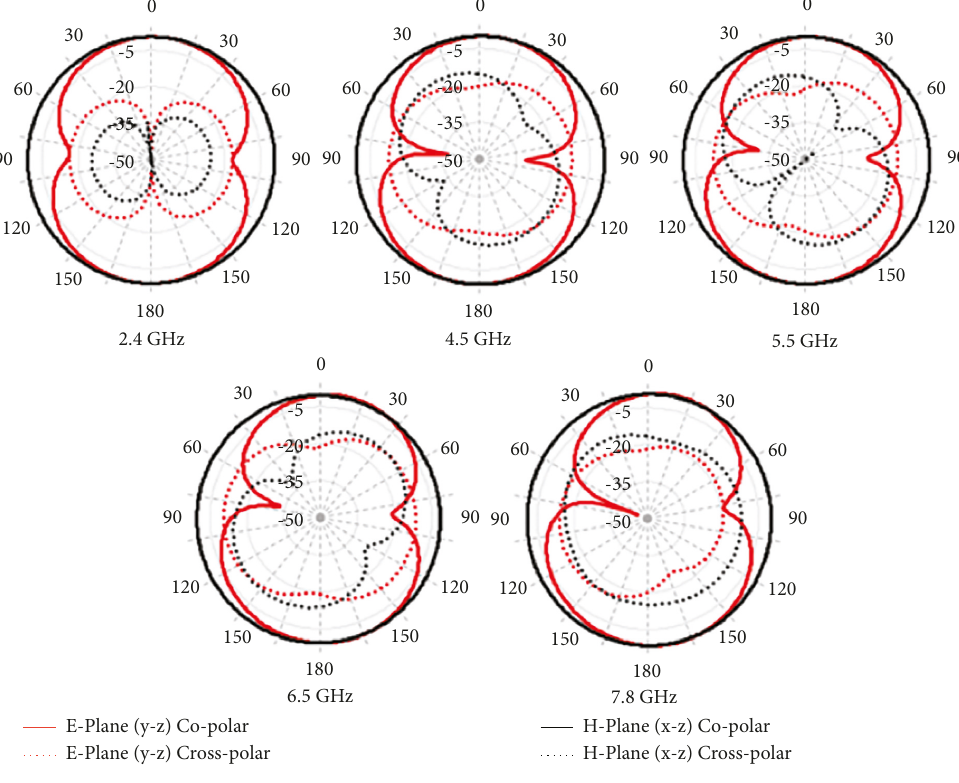
Figure 8: Simulated co and cross-polar patterns of the antenna.